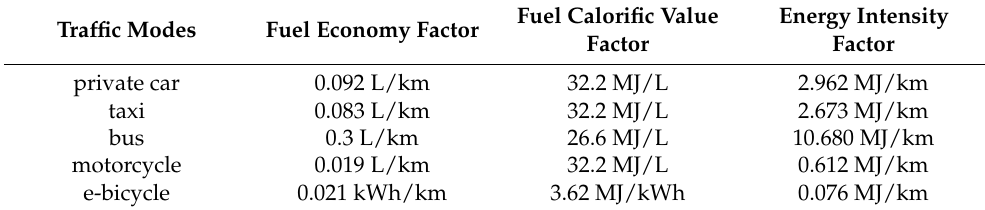
Table 1. Table of energy intensity factors for different traffic